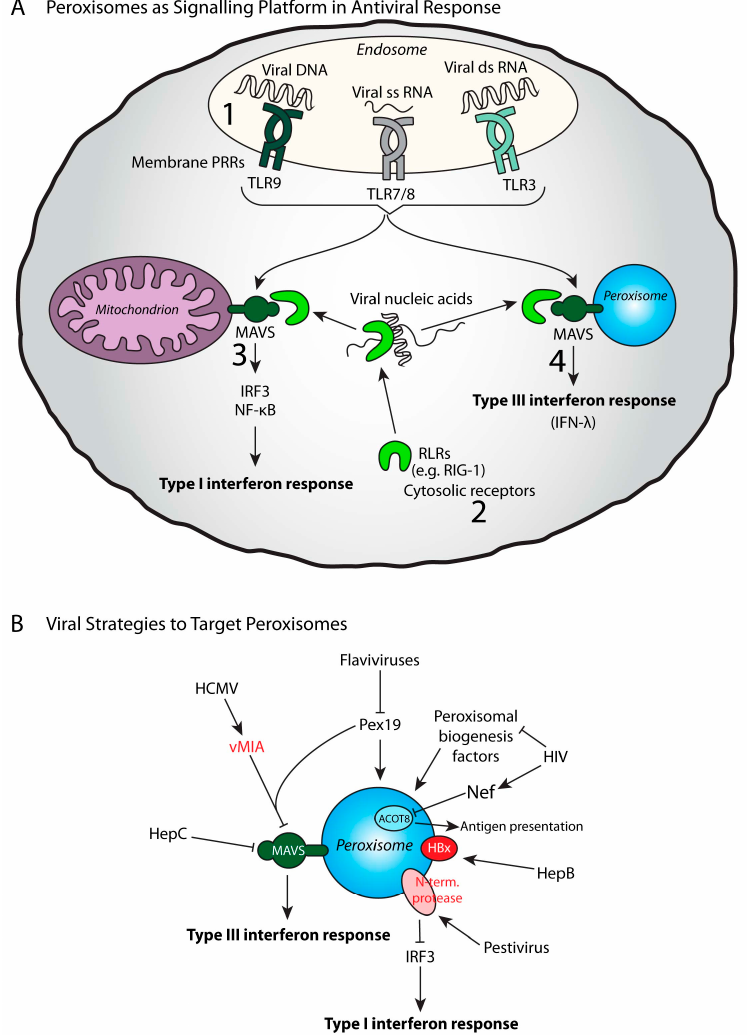
Figure 4. Peroxisomes in an antiviral response. ( A ) Peroxisomes are signaling hubs for the induction of a Type III interferon response by harboring the antiviral signaling protein MAVS. Viral nucleic